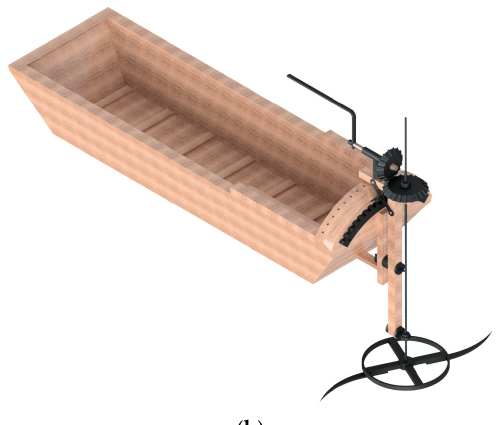
Figure 12. Rendered images of the machine with its two different blades. ( a ) single blade; ( b ) double blade.